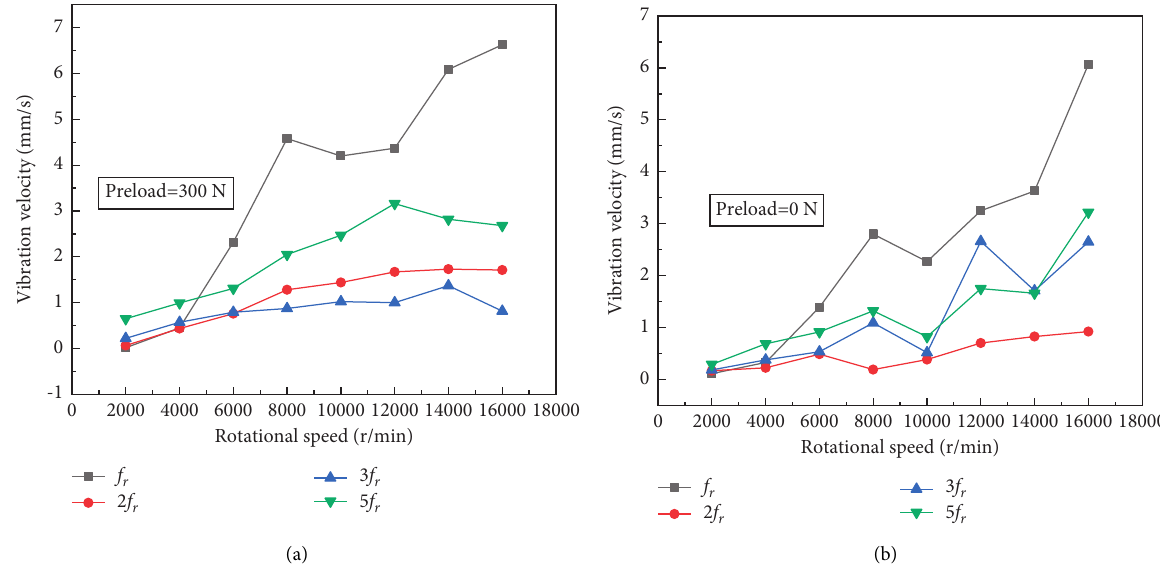
Figure 10: Effect of frequency multiplication on the vibration velocity for Si (a) Condition of applying preload. (b) Condition of no preload.